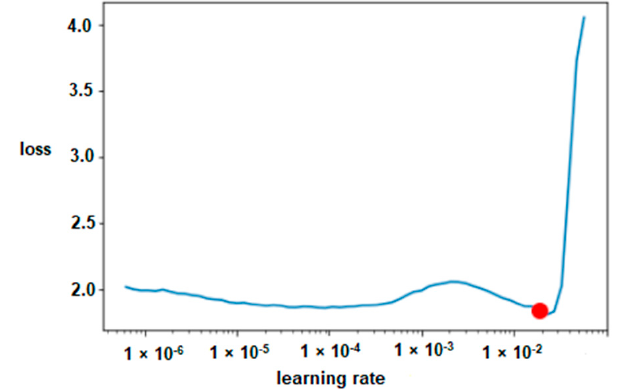
Figure 13. Utilization of Learning rate finder within FastAI library.